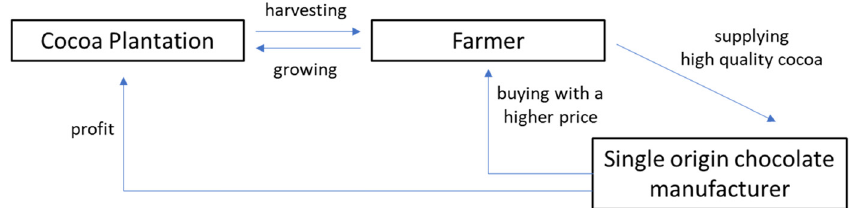
Figure 3: Mutual interrelation among cocoa plantation, farmer and single - origin chocolate